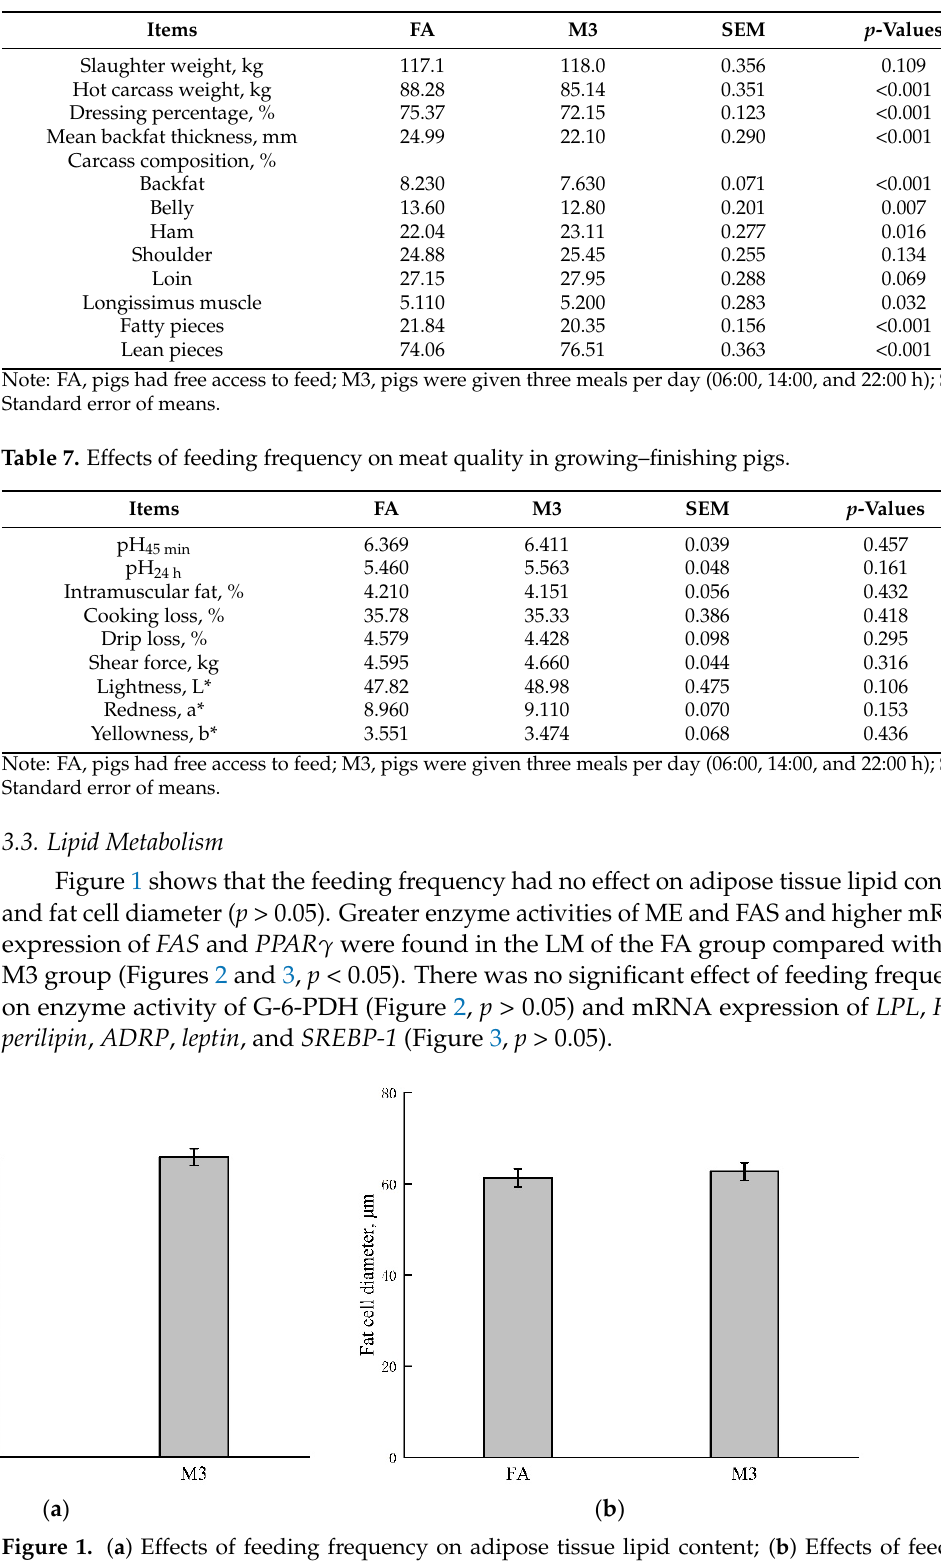
Figure 2. Effects of feeding frequency on enzyme activity of lipid metabolism in growing–finishing pigs. FA, pigs had free access to feed; M3, pigs were given three meals per day (06:00, 14:00, and 22:00 h); * p < 0.05; ME, malic enzyme; G-6-PDH, glucose-6phosphate dehydrogenase; FAS, fatty acid synthase.